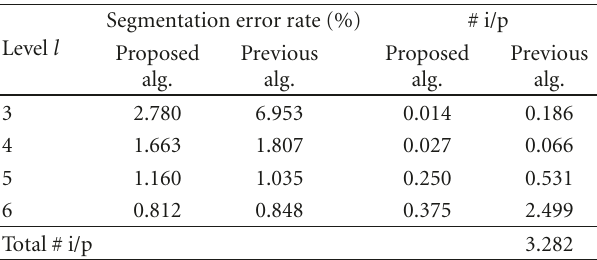
Table 4: Comparisons of performance in terms of segmentation error rates and computational cost measured by number of iteration per pixels (# i/p) for Image II of Figure 5.